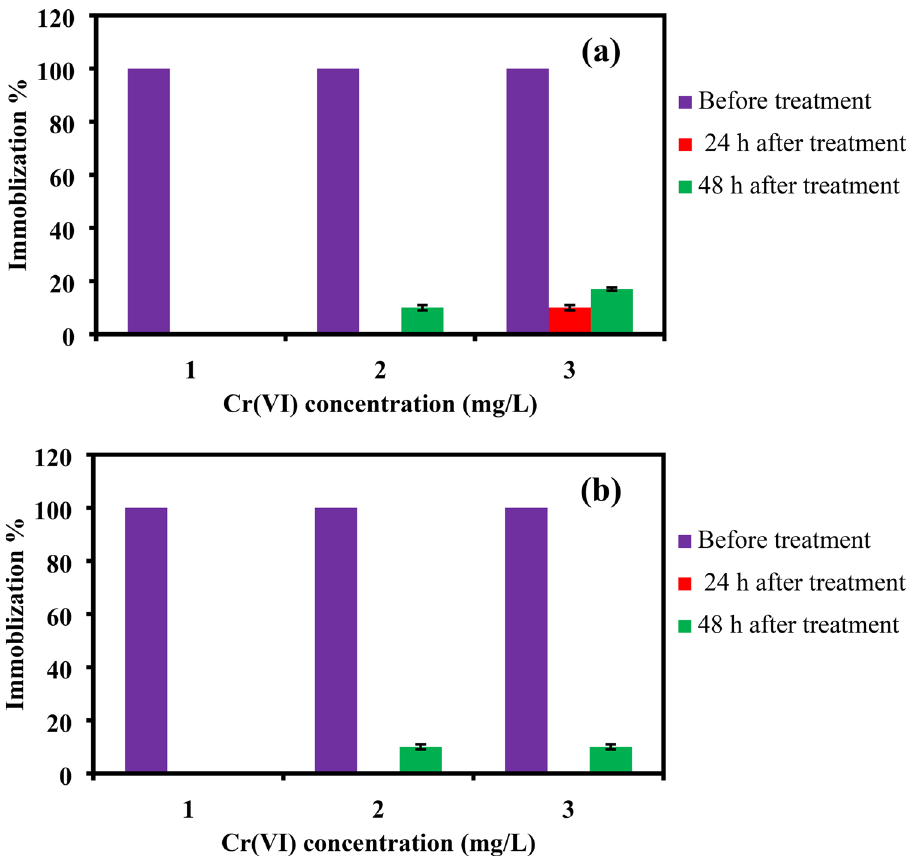
Figure 1. Comparison between the immobilization % of Ostracods ( a ) and Artemia salina ( b ) larvae exposed to different concentrations of Cr(VI) before and after treatment with PANI/Ag (AMPSA)/GO QDs NC for 24 and 48